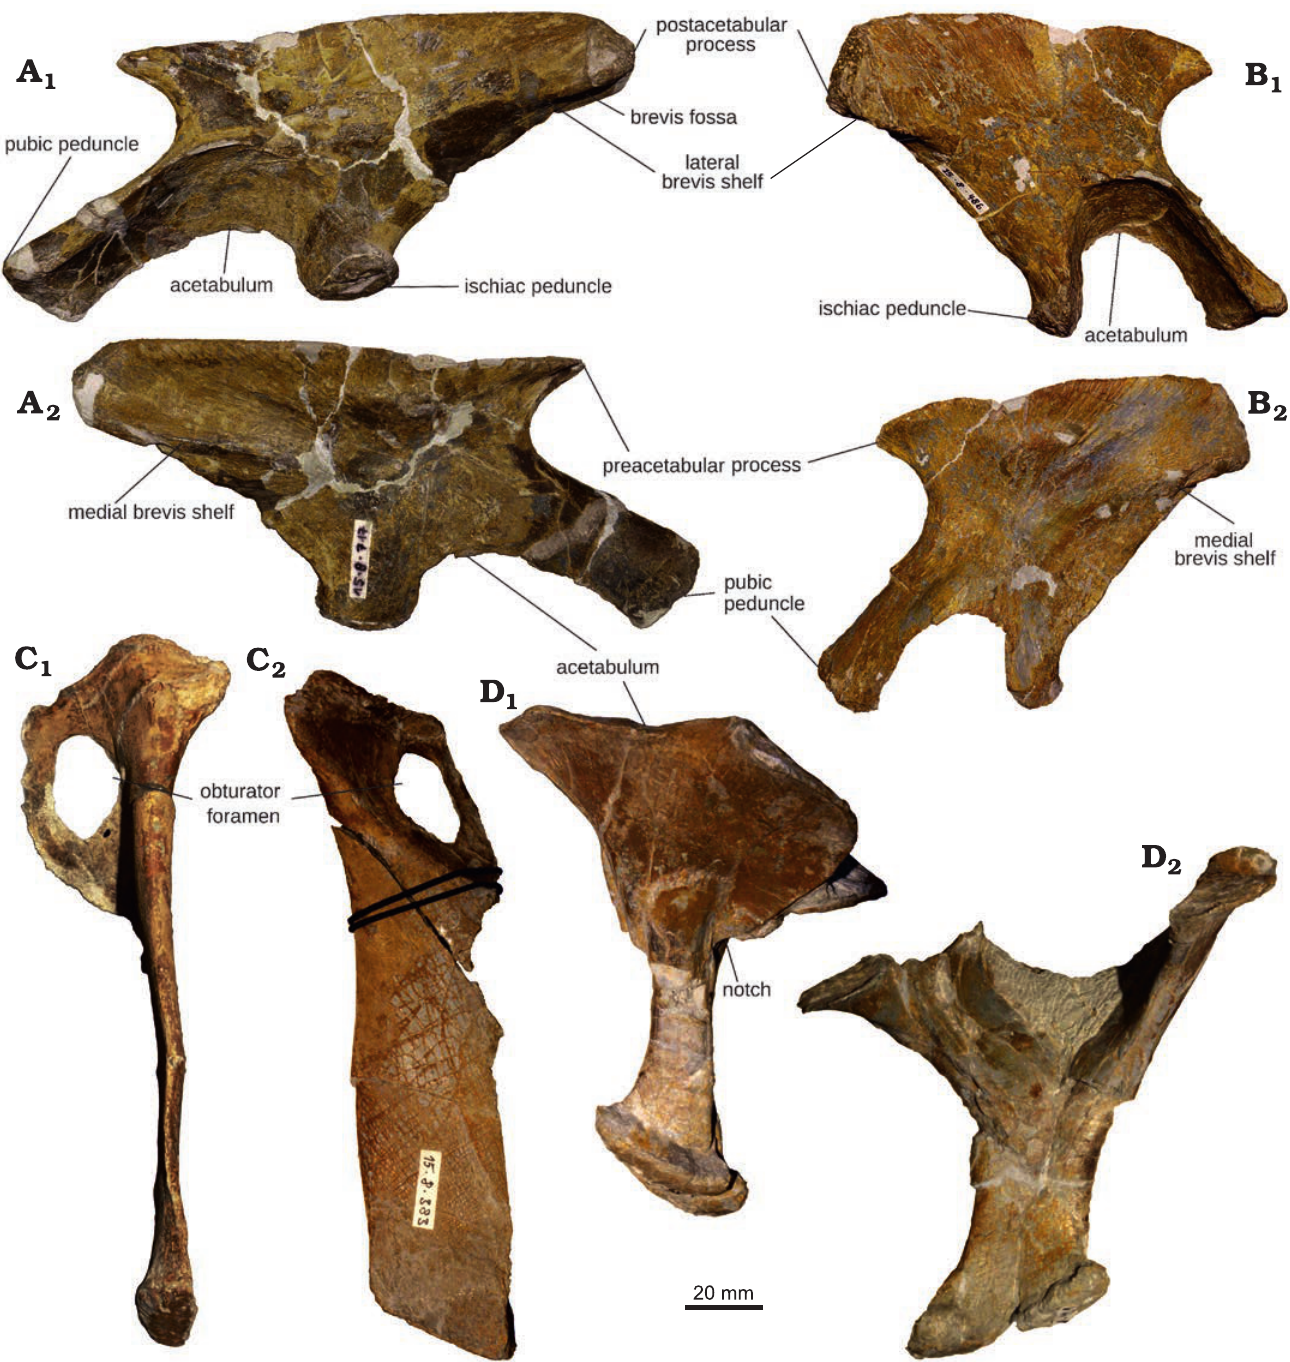
Fig. 10. Pelvic girdle of juvenile Plateosaurus cf. trossingensis Fraas, 1913 skeleton MSF 15.8B. from the Norian of Frick, Switzerland. A . Left ilium, MSF 15.8.717, in lateral (A 1 ) and medial (A 2 ) views. B . Right ilium, MSF 15.8.486, in lateral (B 1 ) and medial (B 2 ) views (note differences due to effects of compaction). C . Right pubis, MSF 15.8.383, in lateral (C 1 ) and anterior (C 2 ) views. D . Articulated ischia, MSF 15.8.421, in posterior (D 1 ) and right lateral (D 2 )